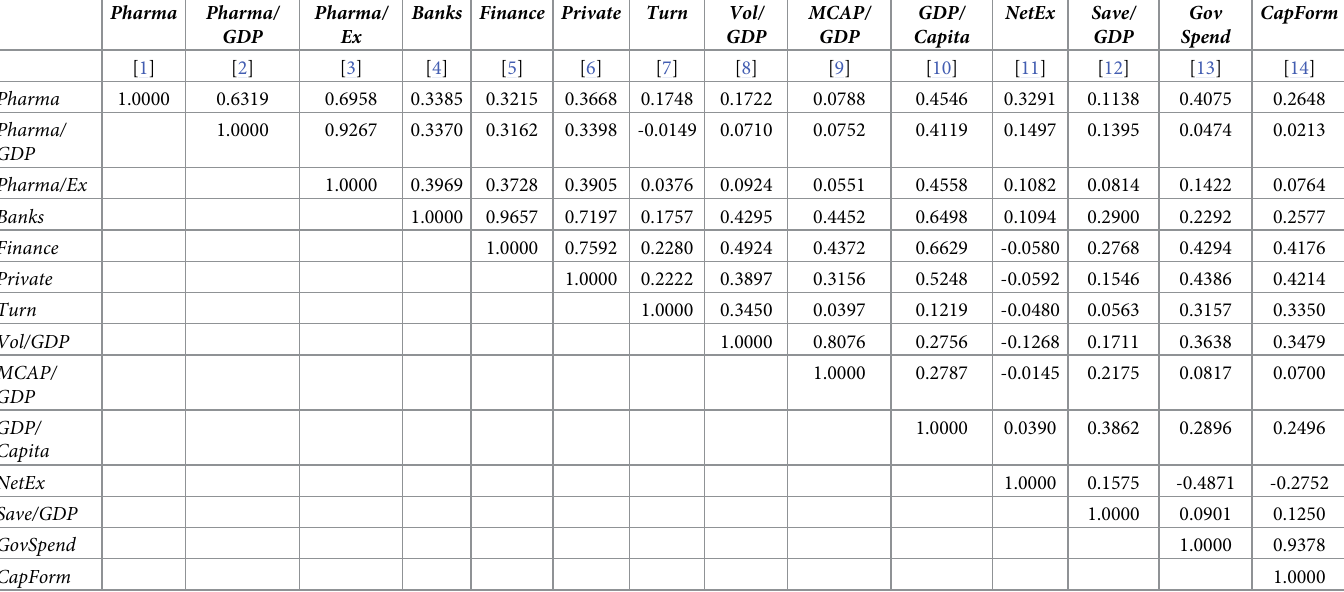
Table 2. Correlation